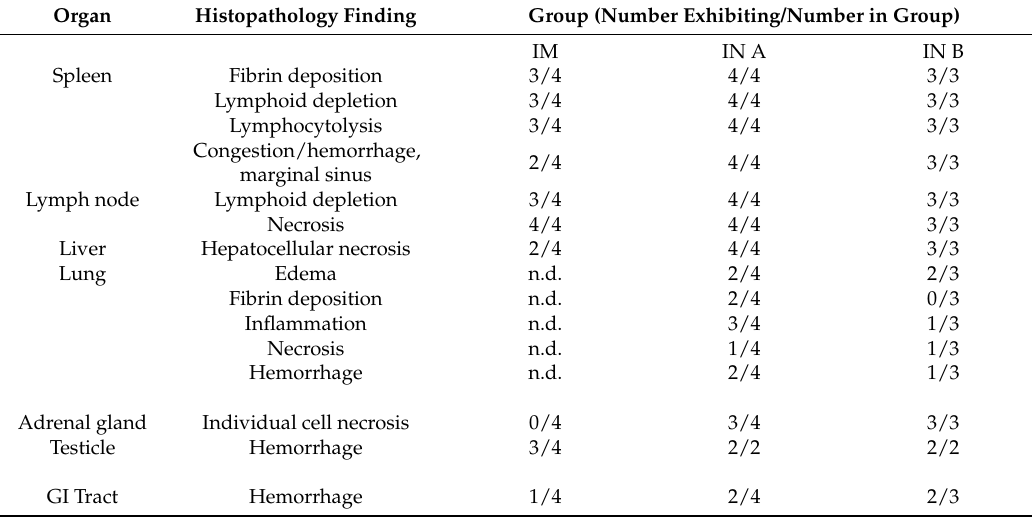
Table 3. Summary of histopathology